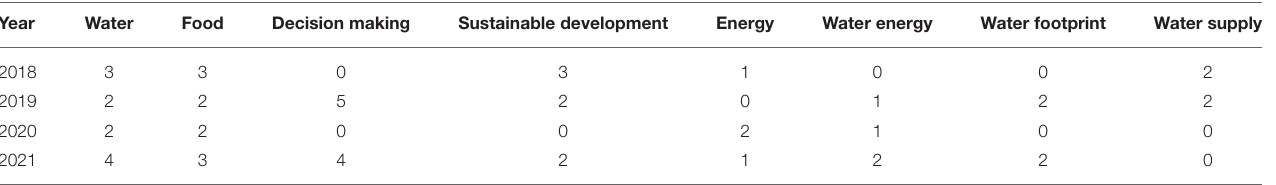
TABLE 3 | Frequent key words plus in WEF